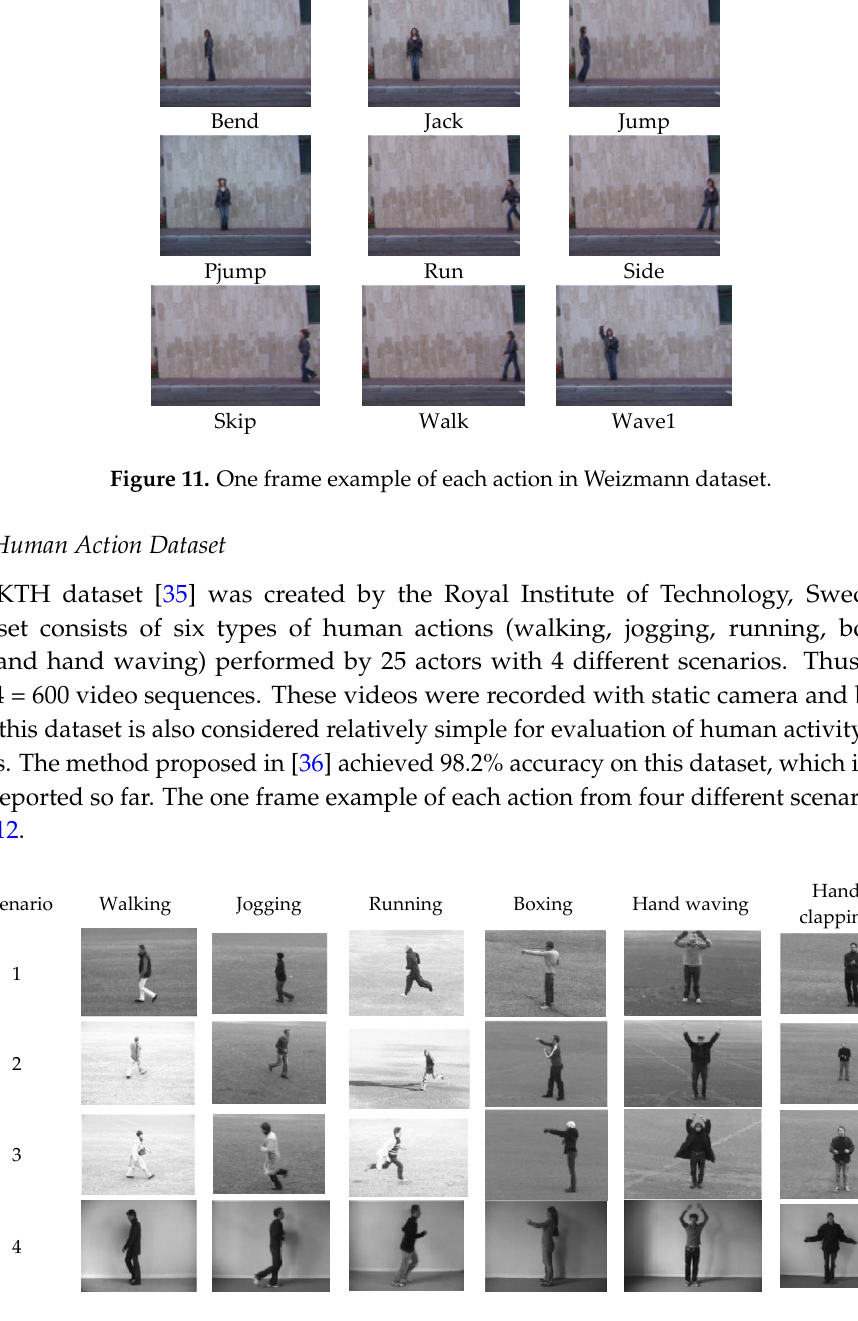
Figure 12. One frame example of each action from four different scenarios in the KTH dataset.